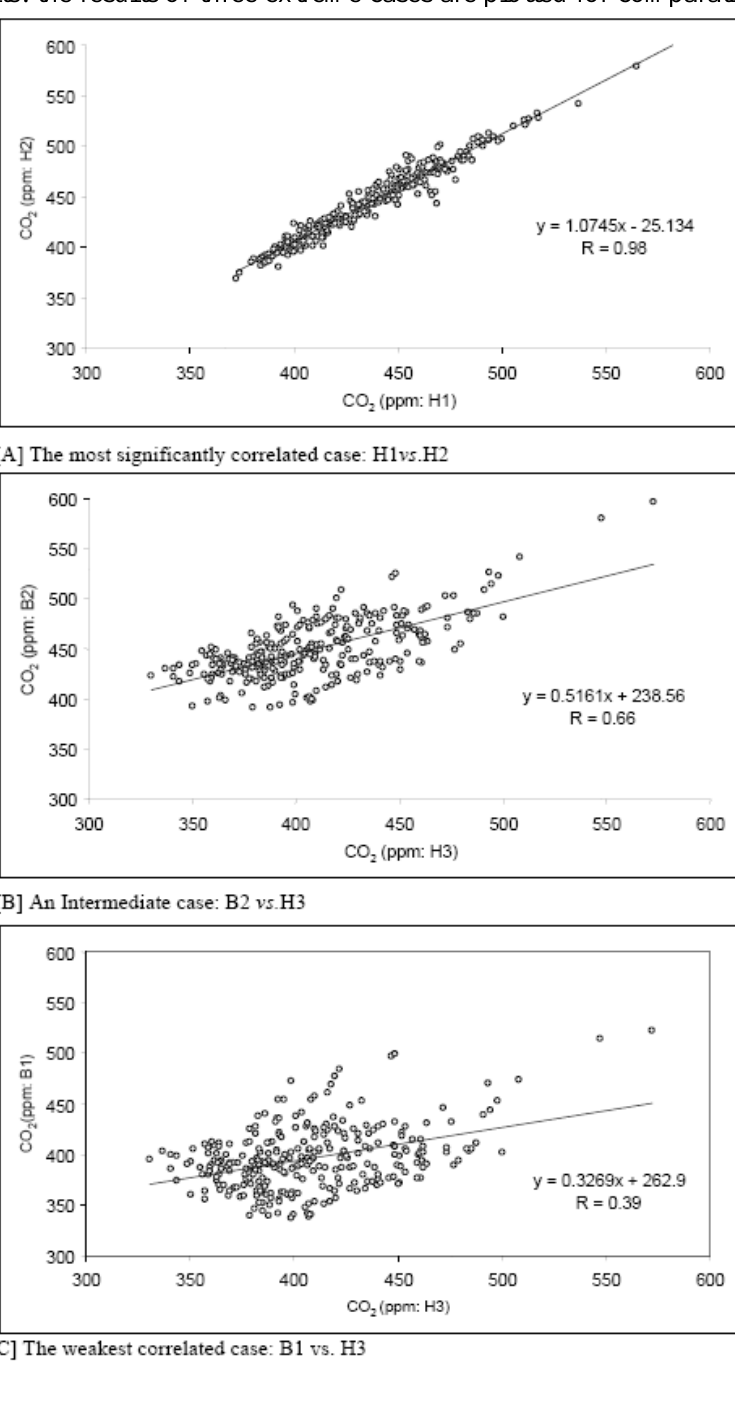
Figure 6. Comparison of correlation analysis patterns between different matching pairs of sensor units: the results of three extreme cases are plotted for comparative